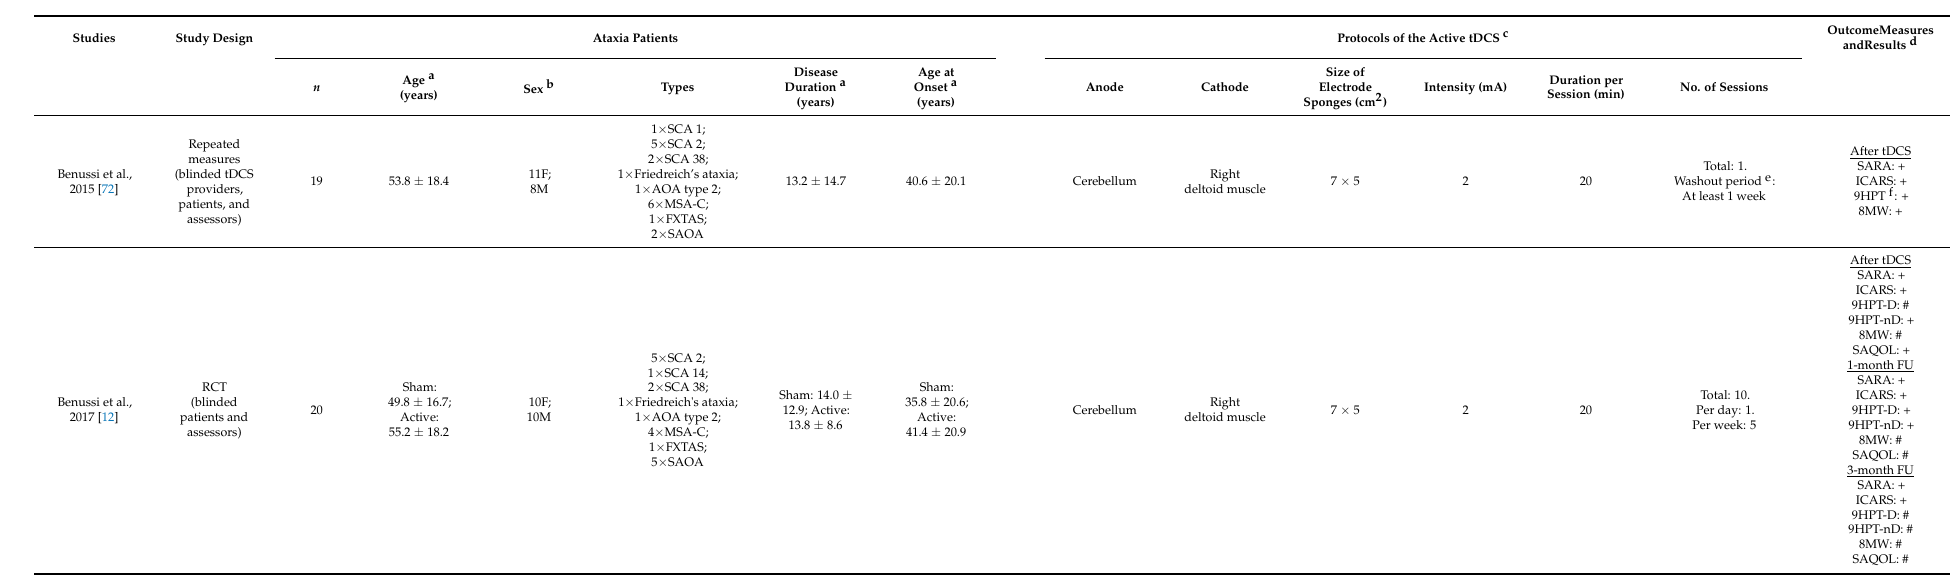
Table 1. Characteristics of the selected